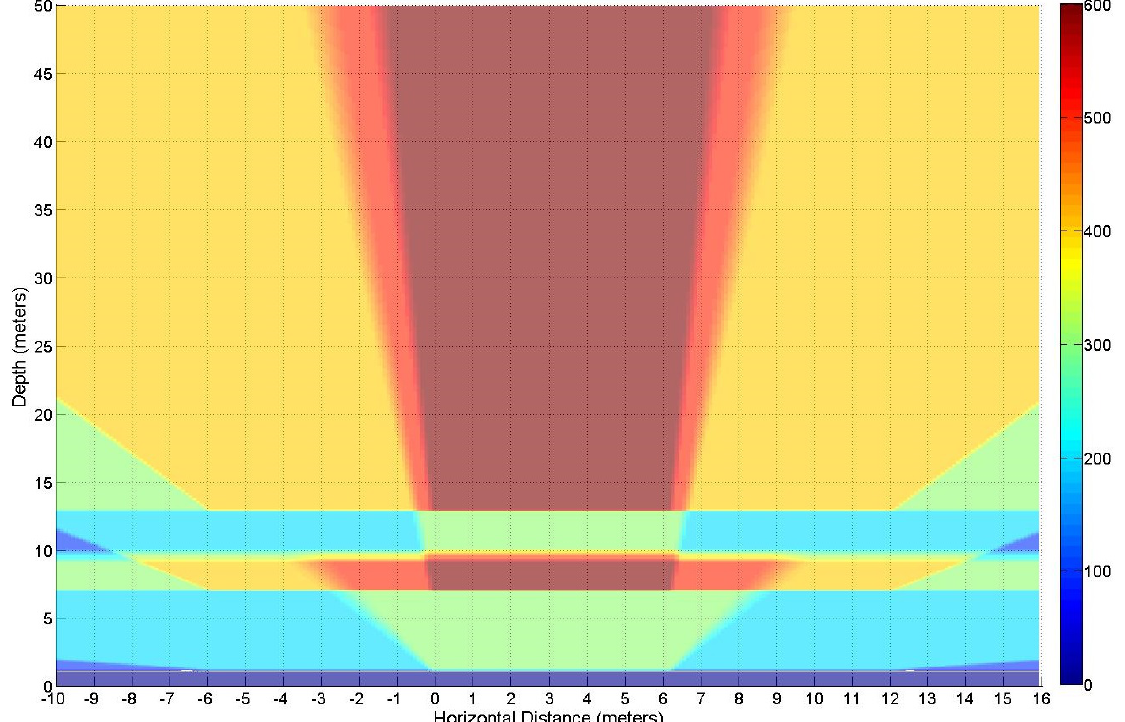
Figure 4. Number of emitters (LEDs) viewed from the target area. The observation area is 50.00 by 26.00 m and is located at the height of 0.00 m. The window being observed is at 4.20 m of height and located between the 0.00 to the 6.00 m in the horizontal